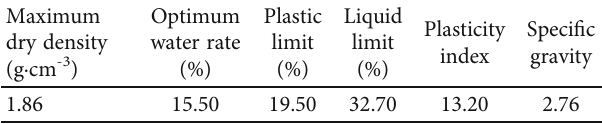
Table 5: Physical-mechanical parameters of silty